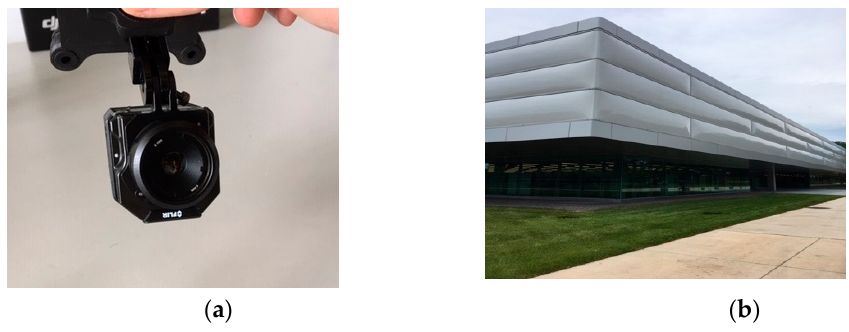
Figure 5. Instruments used for emissivity data collection and building façade project. ( a ) IR sensor: Flir Vue Pro-R 640 9 mm camera; and ( b ) façade for experimentation.